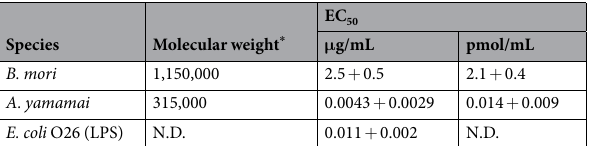
Table 1. Molecular weights and EC 50 values of the purified polysaccharides. * The molecular weight of the polysaccharide isolated from A. yamamai is based on Ohta et al . 8,9 .